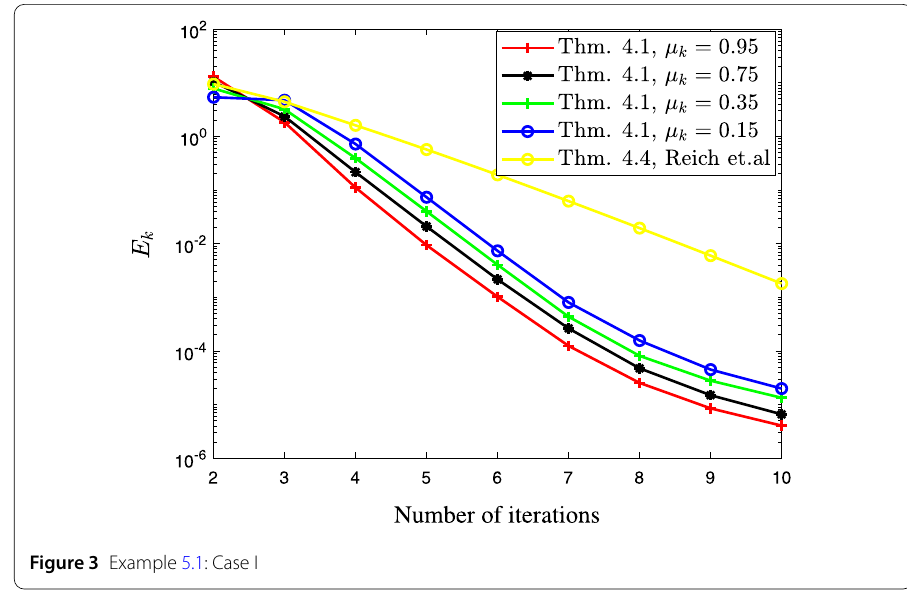
Figure 3 Example 5.1: Case I